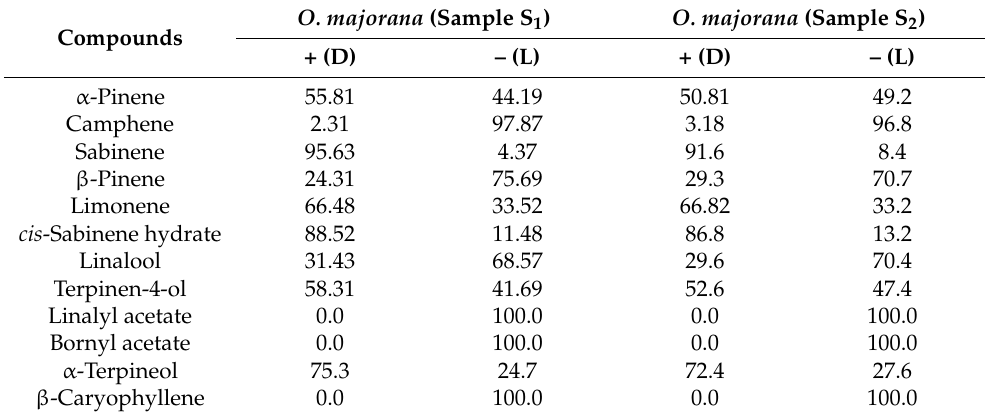
Table 3. Enantiomeric distributions of chiral compounds in EOs of Origanum majorana L. from Nepal.